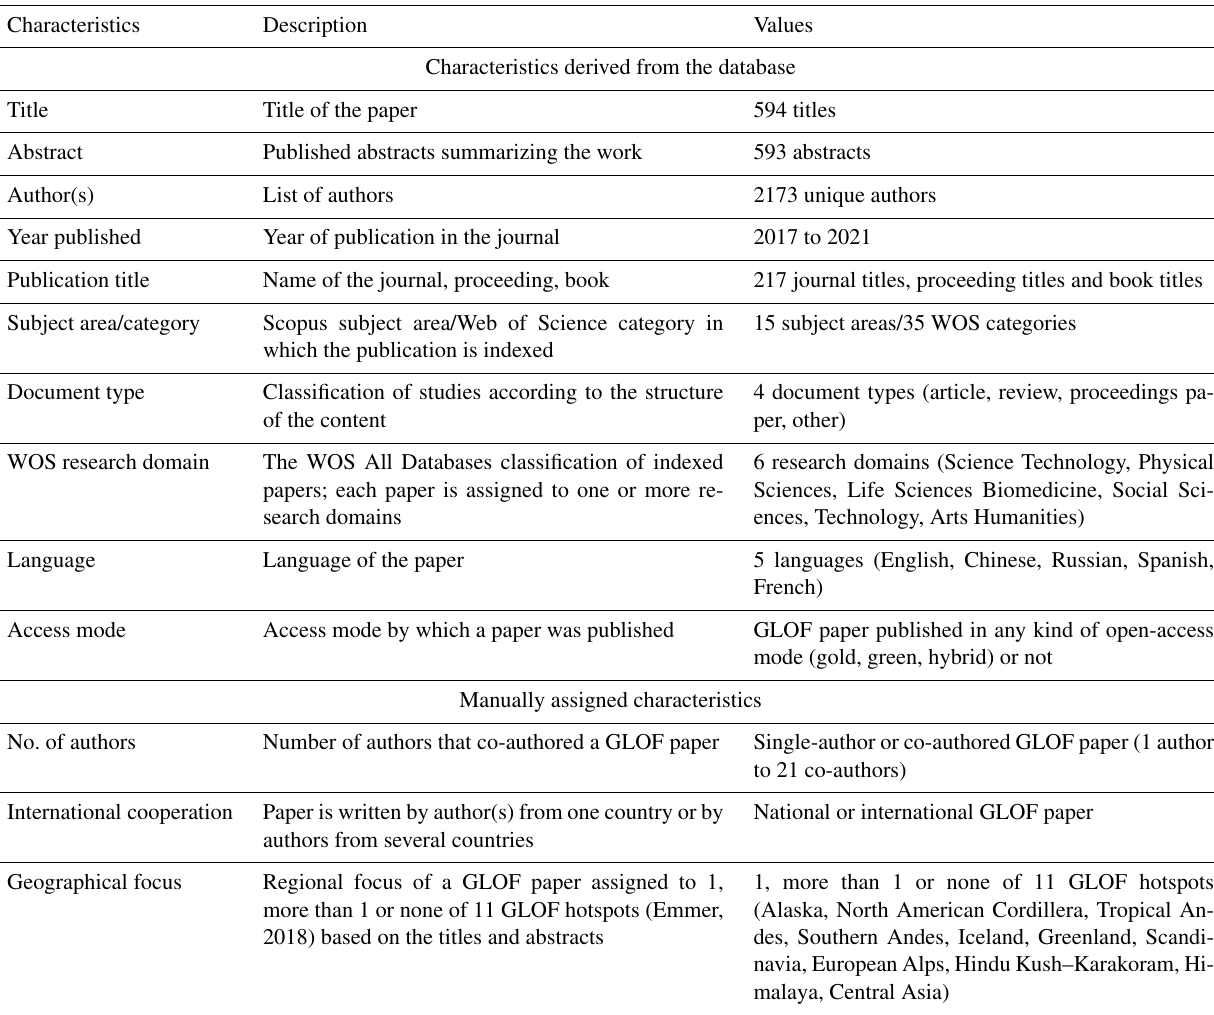
Table 1. Characteristics of GLOF papers analysed in this study.